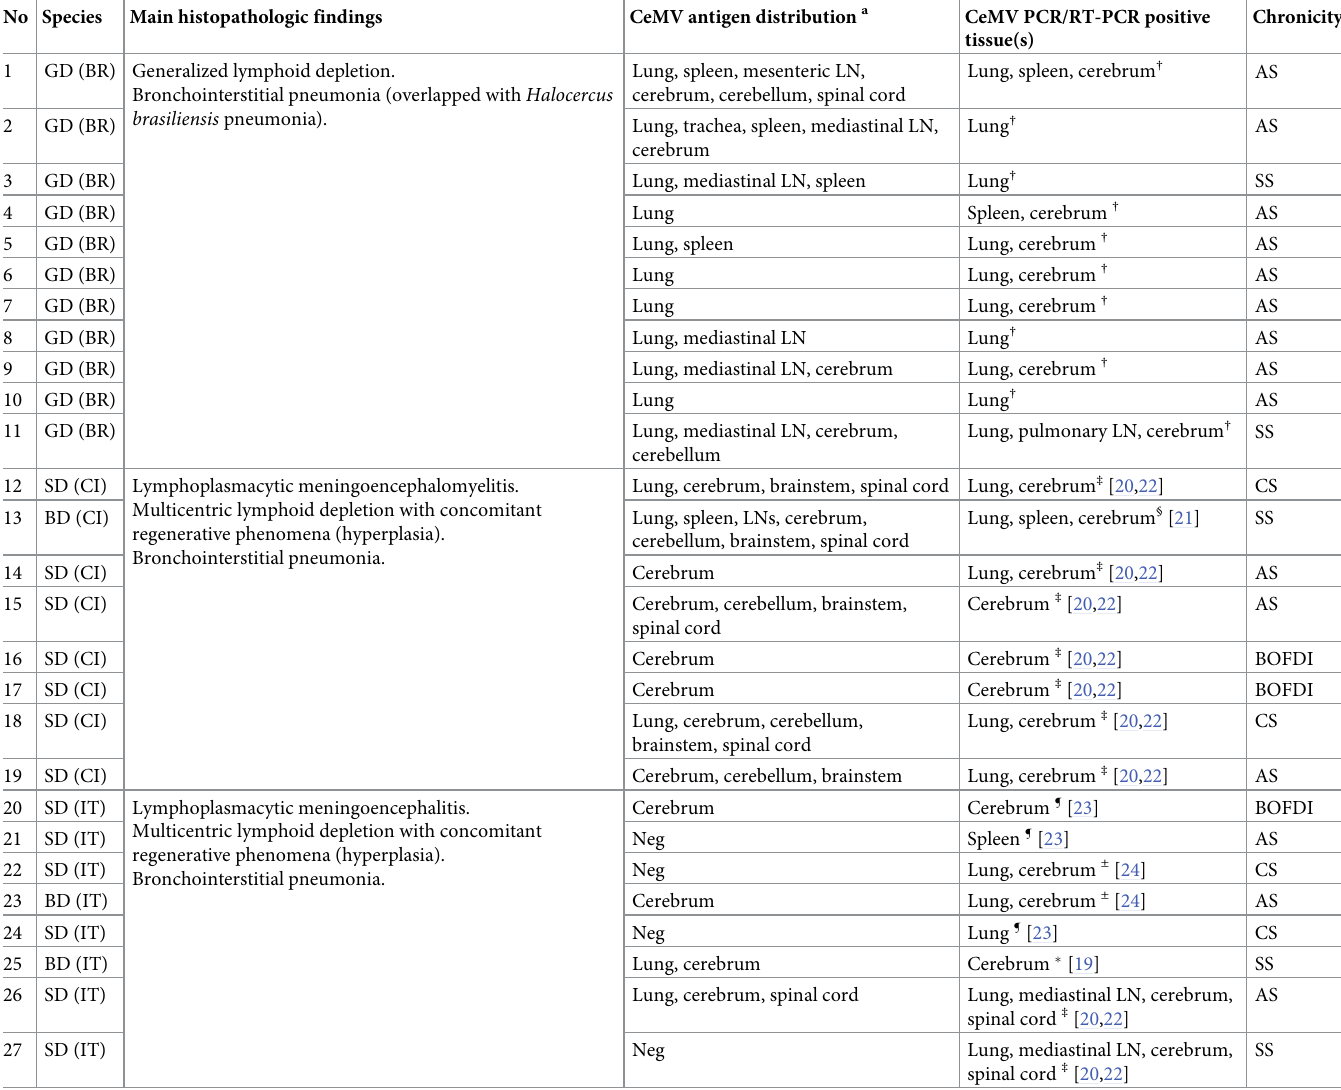
Table 2. Summary of main lesions, morbilliviral antigen distribution and PCR-positive tissues (lung, lymph nodes, spleen, central nervous system), and suspected infection chronicity by geographic area and species. No Species GD (BR) Generalized lymphoid depletion. Bronchointerstitial pneumonia (overlapped with Halocercus brasiliensis pneumonia).